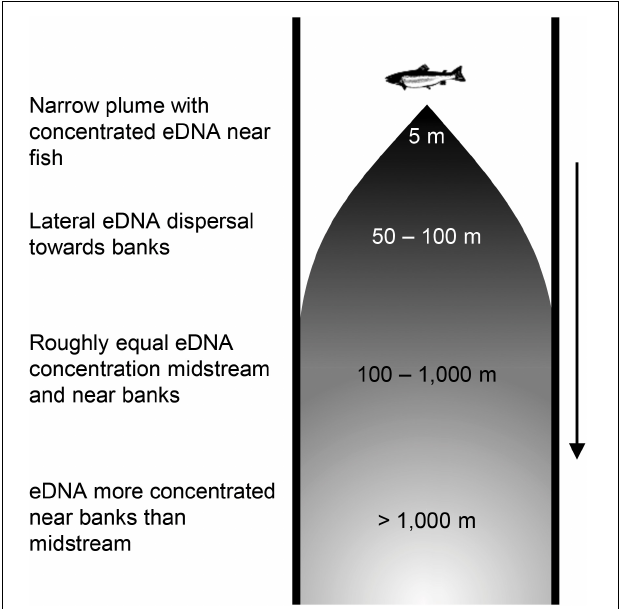
FIGURE 1 | Hypothesized eDNA plume in rivers and streams. See section “Results” for explanation of distance estimates and plume phases.